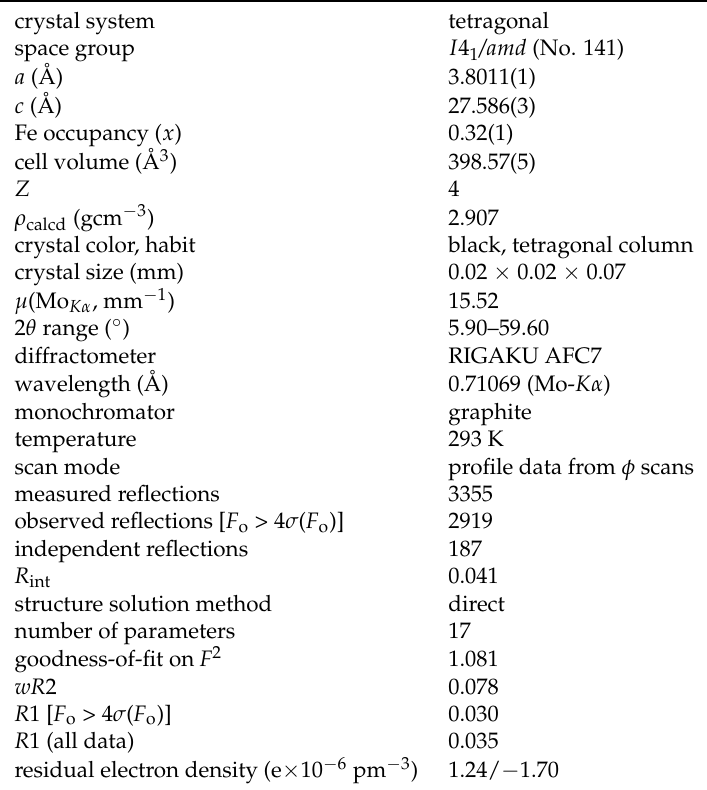
Figure 3. X-Ray diffraction pattern measured on ground single crystals of Li 2 Sr[(Li 1 − x Fe x )N] 2 (Co- K α radiation, λ = 1.78892Å). Tick marks correspond to reflection positions of Li 2 Sr[(Li 1 − x Fe x )N] 2 . Table 1. Single crystal structure refinement for Li 2 Sr[(Li 1 − x Fe x )N] 2